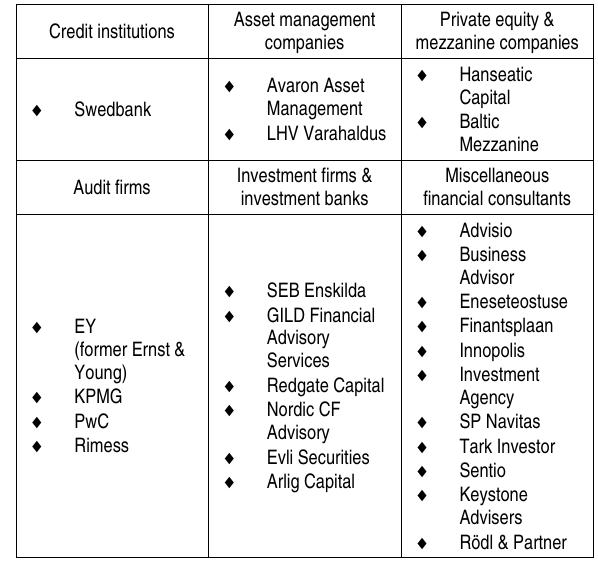
Table 2. Sample composition by company